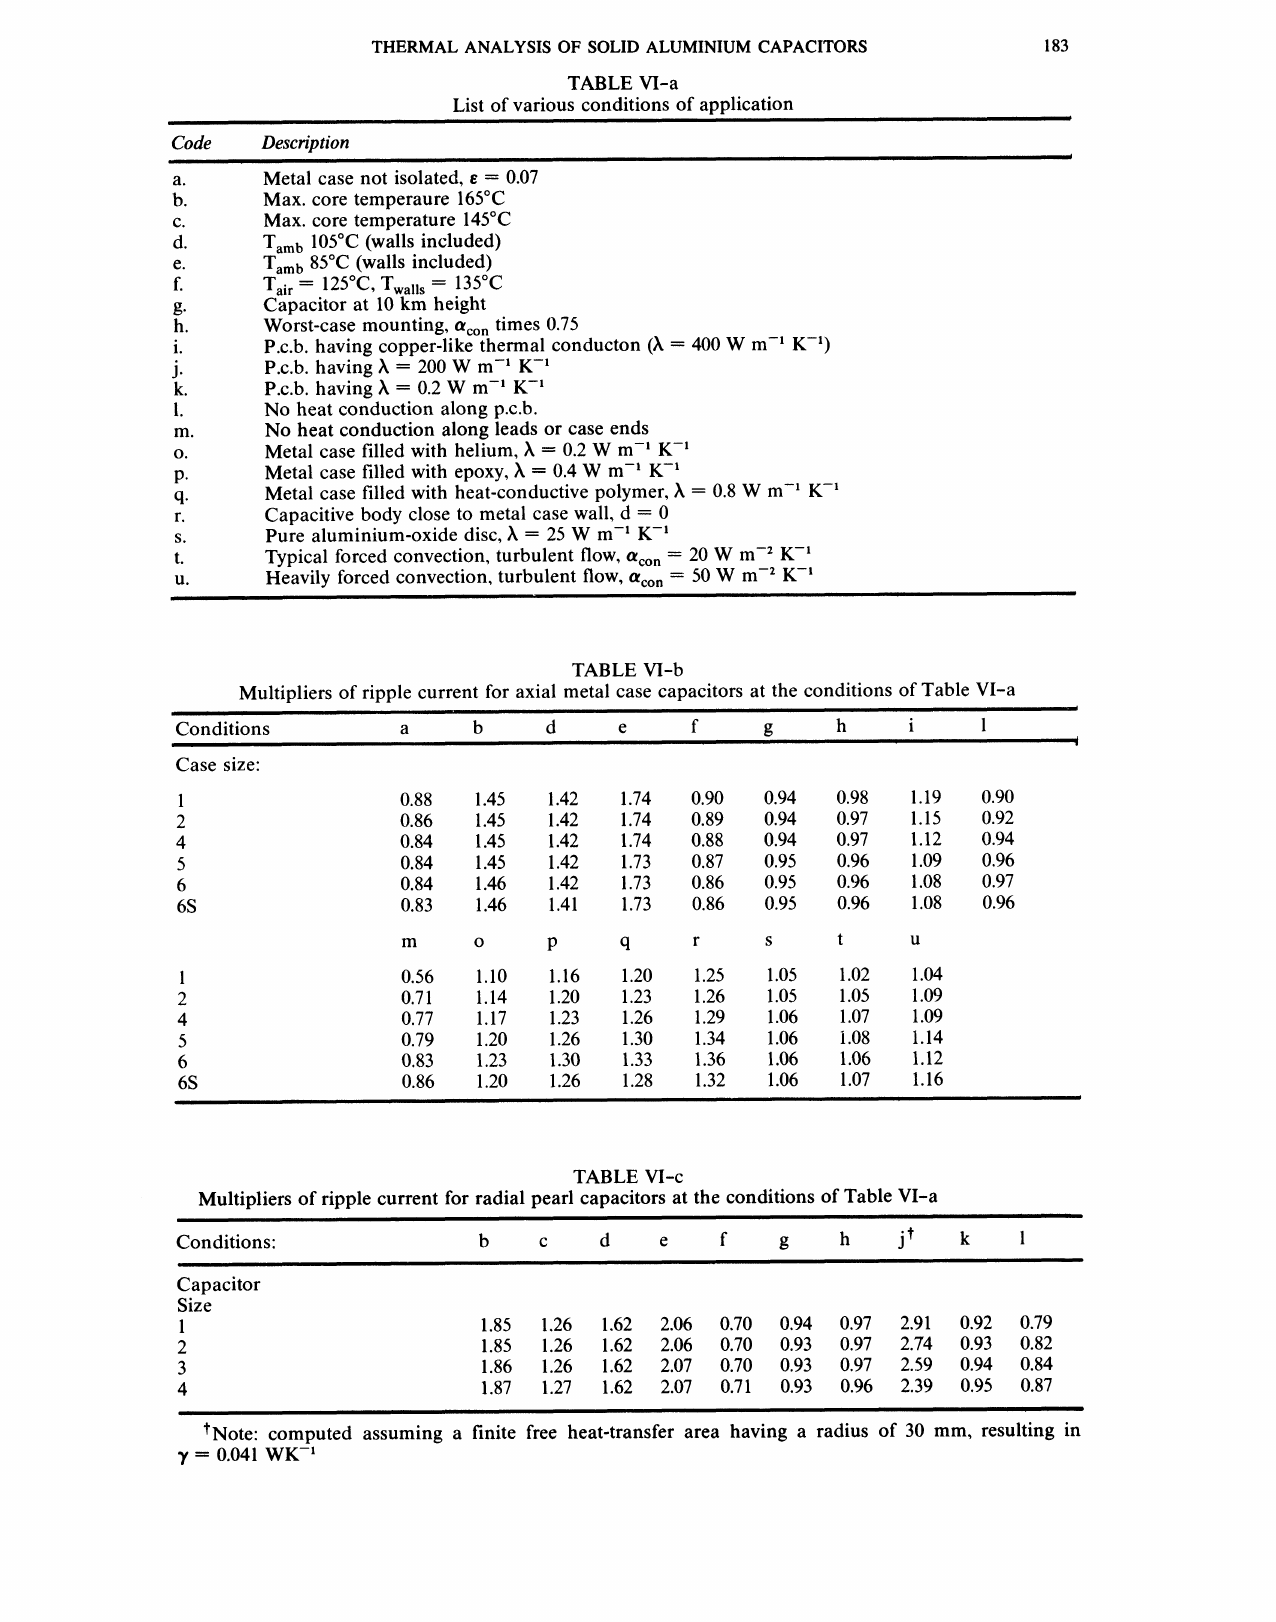
TABLE VI-c Multipliers of ripple current for radial pearl capacitors at the conditions of Table